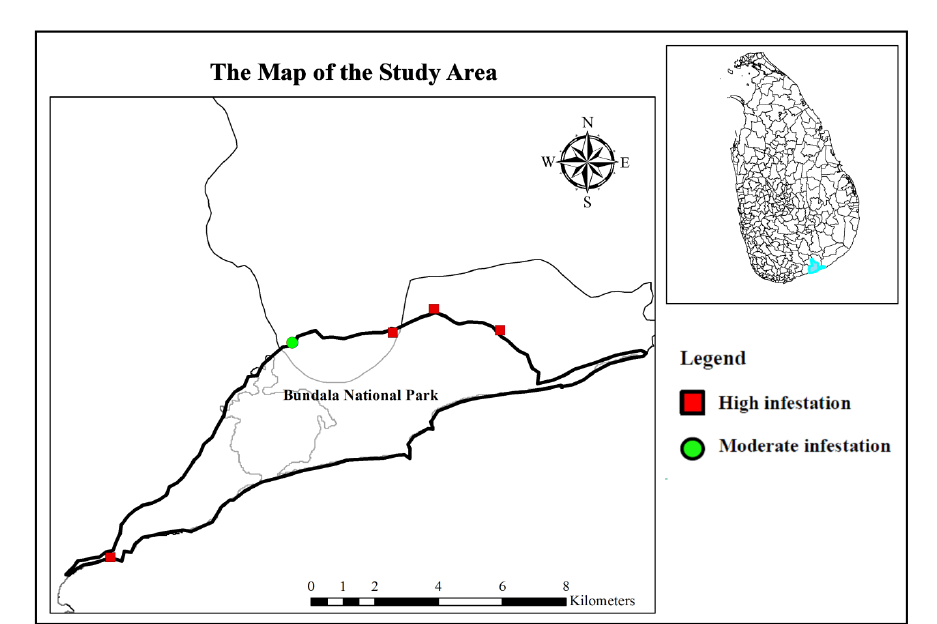
Figure 1: Map of the study area in the Bundala National Park showing areas of high infestation and moderate infestation of O. dillenii by D. opuntiae.